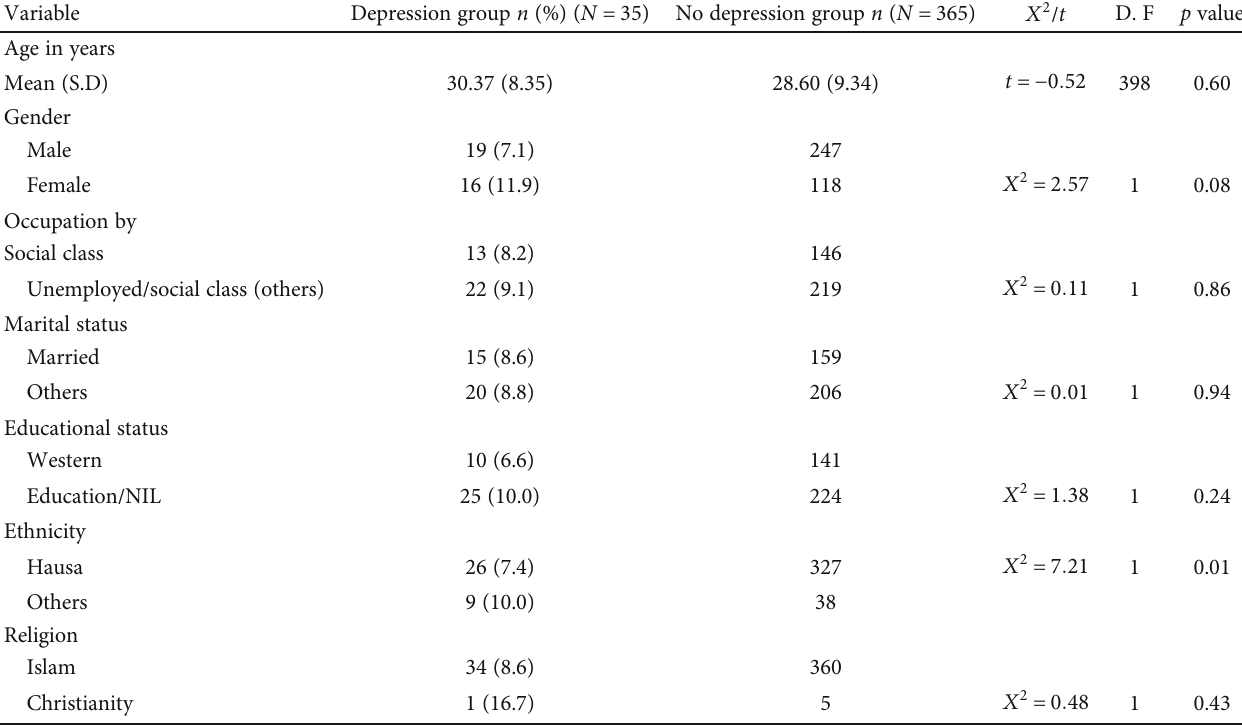
Table 1: Comparison of the sociodemographic characteristics of the depressed and nondepressed study groups ( n = 400 ).